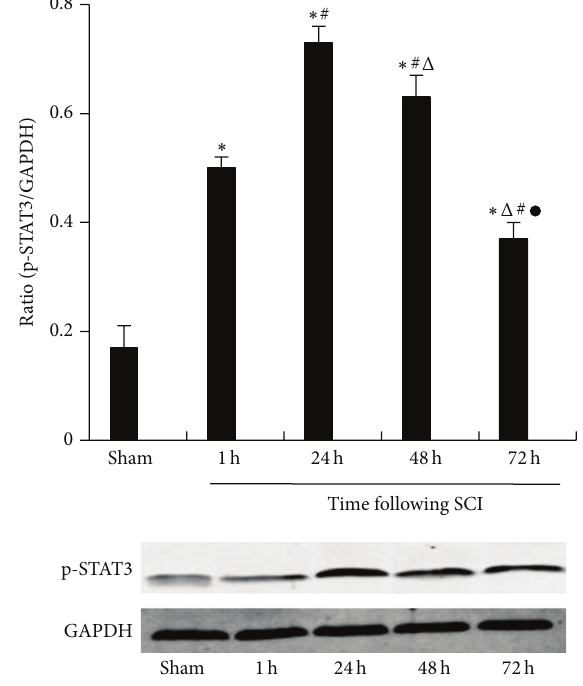
Figure 4: Phosphorylation of STAT3 protein levels in the spinal cord. The protein levels of p-STAT3 in the spinal cord tissues in different groups, as measured by western blotting analyses. The spinal cord tissues levels were 0.17 ± 0.04 , 0.50 ± 0.02 , 0.73 ± 0.03 , 0.63±0.04 , and 0.37±0.03 , respectively, in the sham-operated group ( 𝑛 = 15 ) and SCI groups at 1h ( 𝑛 = 15 ), 24 h ( 𝑛 = 15 ), 48 h ( 𝑛 = 15 ), and 72 h ( 𝑛 = 15 ) rats. The data are presented as the mean ± the SE. ∗ 𝑃 < 0.05 versus sham, # 𝑃 < 0.05 versus 1h, △ 𝑃 < 0.05 versus 24 h, and e 𝑃 < 0.05 versus 48